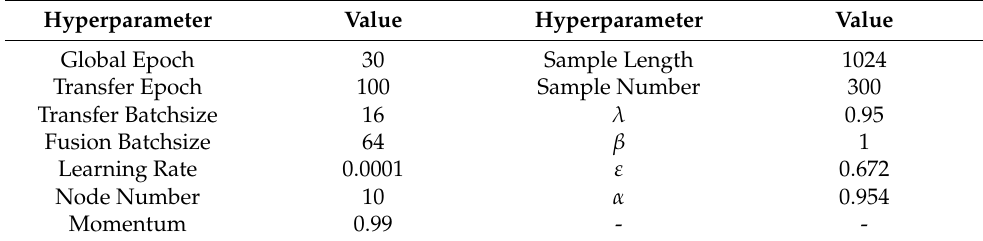
Table 2. Basic hyperparameters